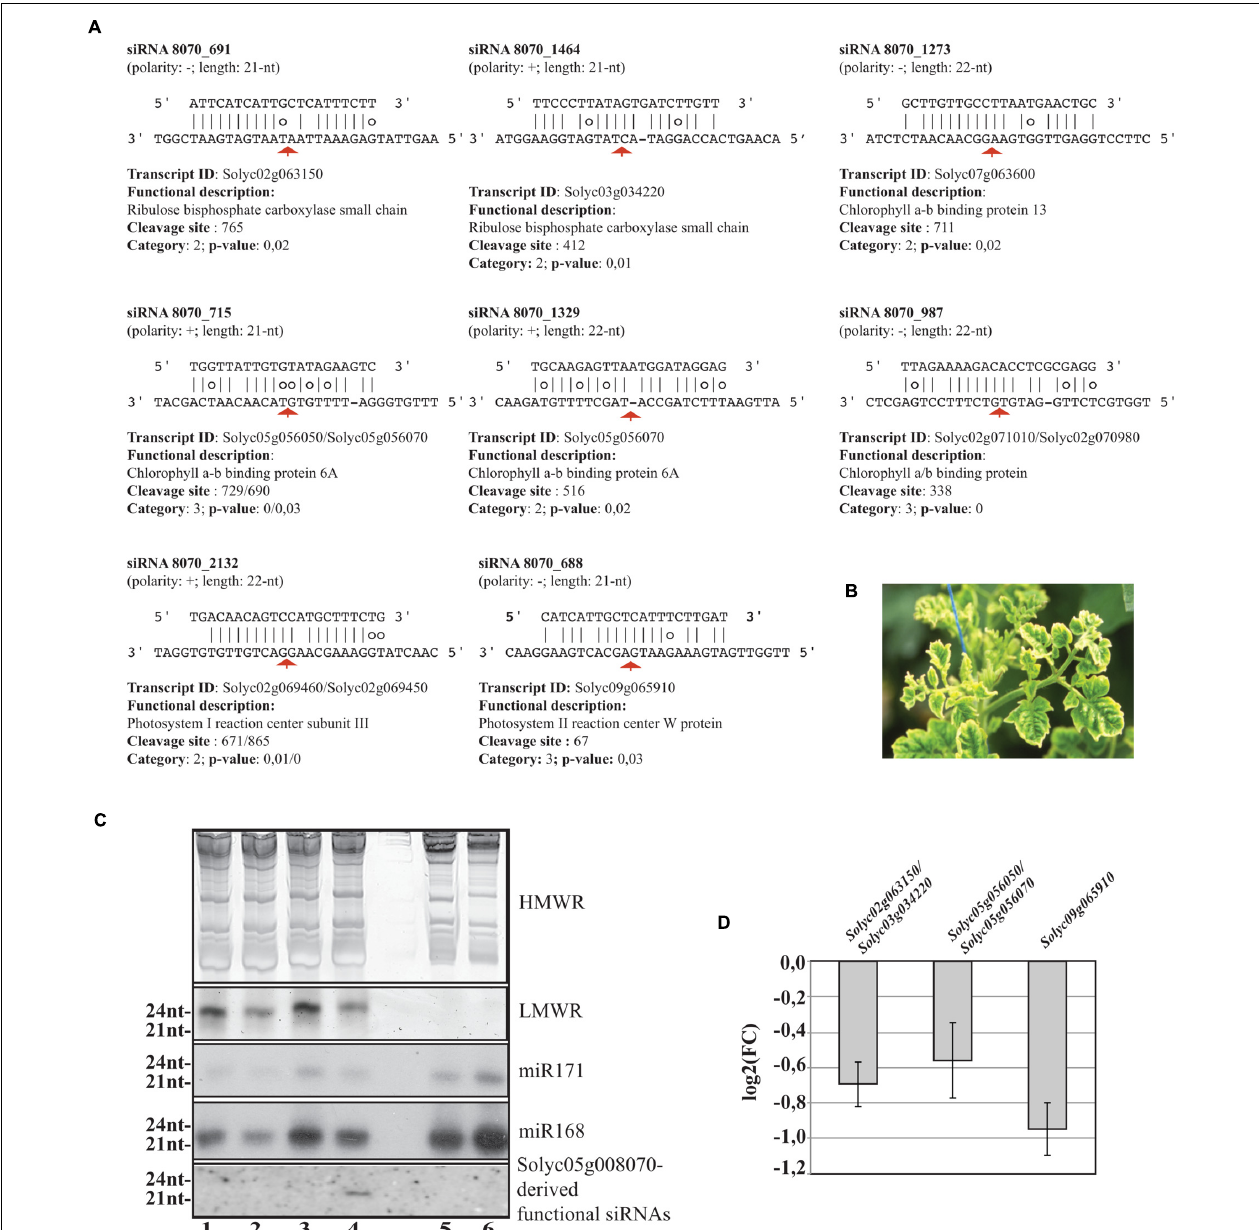
FIGURE 7 | Functional secondary siRNAs and expression of genes involved in photosynthesis. (A) Functional 21nt and 22nt-long secondary siRNAs from the NBS–LRR transcript Solyc05g00807 0 and targeted transcripts. Transcripts sharing conserved miRNA target sites are indicated and separated by “/”. Red arrows indicate the cleavage sites. (B) Typical leaf yellowing induced by TYLCSV in virus-infected tissues. (C) Short RNA Northern blot analysis. High- or low-molecular weight RNAs patterns (HMWR and LMWR, respectively). Lanes 1 and 3: mock-inoculated Solanum lycoperscum , Lane 2: total RNA from TYLCSV-inoculated plant tissues not showing yellowing sympthoms, Lane 4: total RNA from TYLCSV-inoculated plant tissues showing typical yellowing symptoms. Lanes 5 and 6, Arabidopsis thaliana and Nicotiana benthamiana total RNA, respectively. (D) qRT-PCR (three biological replicates and two technical replicates) for the expression